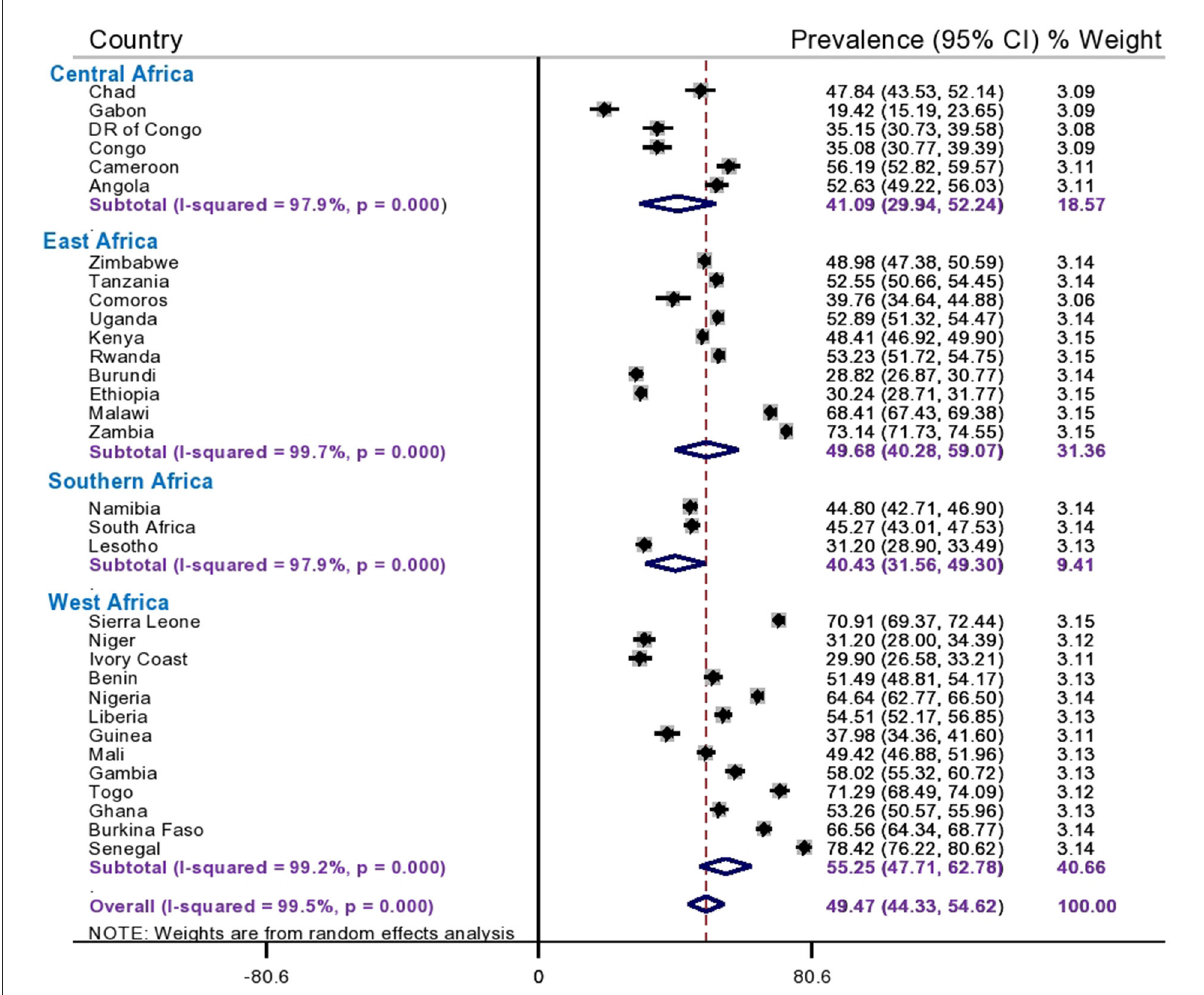
FIGURE2 Subgroup analysis of informed choice of contraceptive methods by region in Sub-Saharan